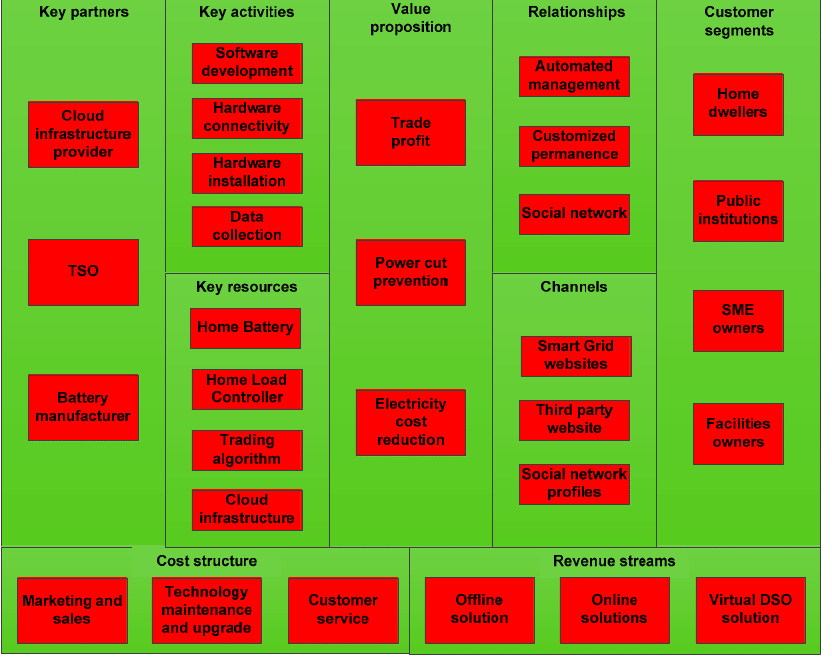
Figure 4. Business canvas model for symbiosis between end users/clients and a third party supplier.